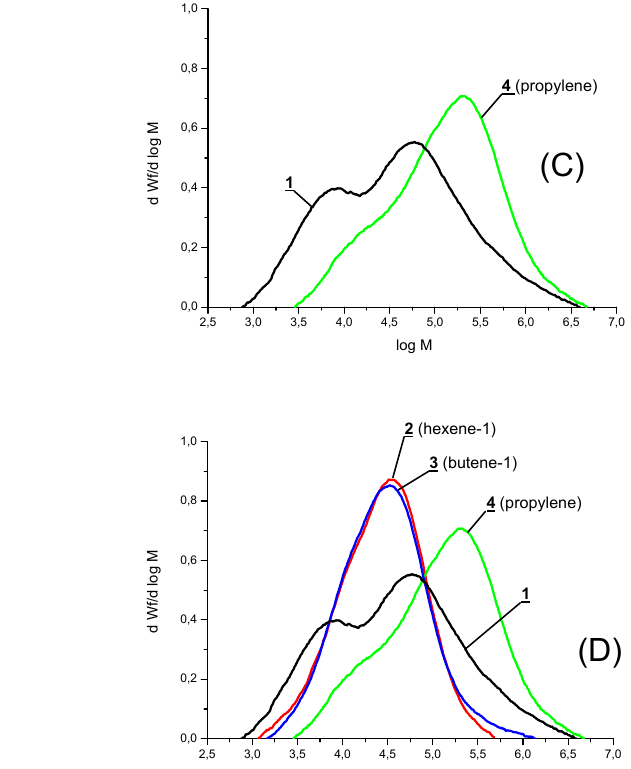
Figure 7. Data on the deconvolution of MWD curves of PE samples 1 and 2 obtained from ethylene polymerization in the absence of α -olefins ( A ) and from ethylene polymerization with hexene-1 ( B ). Data presented in Figure 7 and Table 4 show that the addition of hexene-1 into eth- ylene polymerization leads mainly to a decrease in the M w value for the high-molecular-mass part C2 for sample 2 in comparison with sample 1 (from 130 kg/mol to 56 kg/mol). This means that active centers producing high-molecular-mass compo-